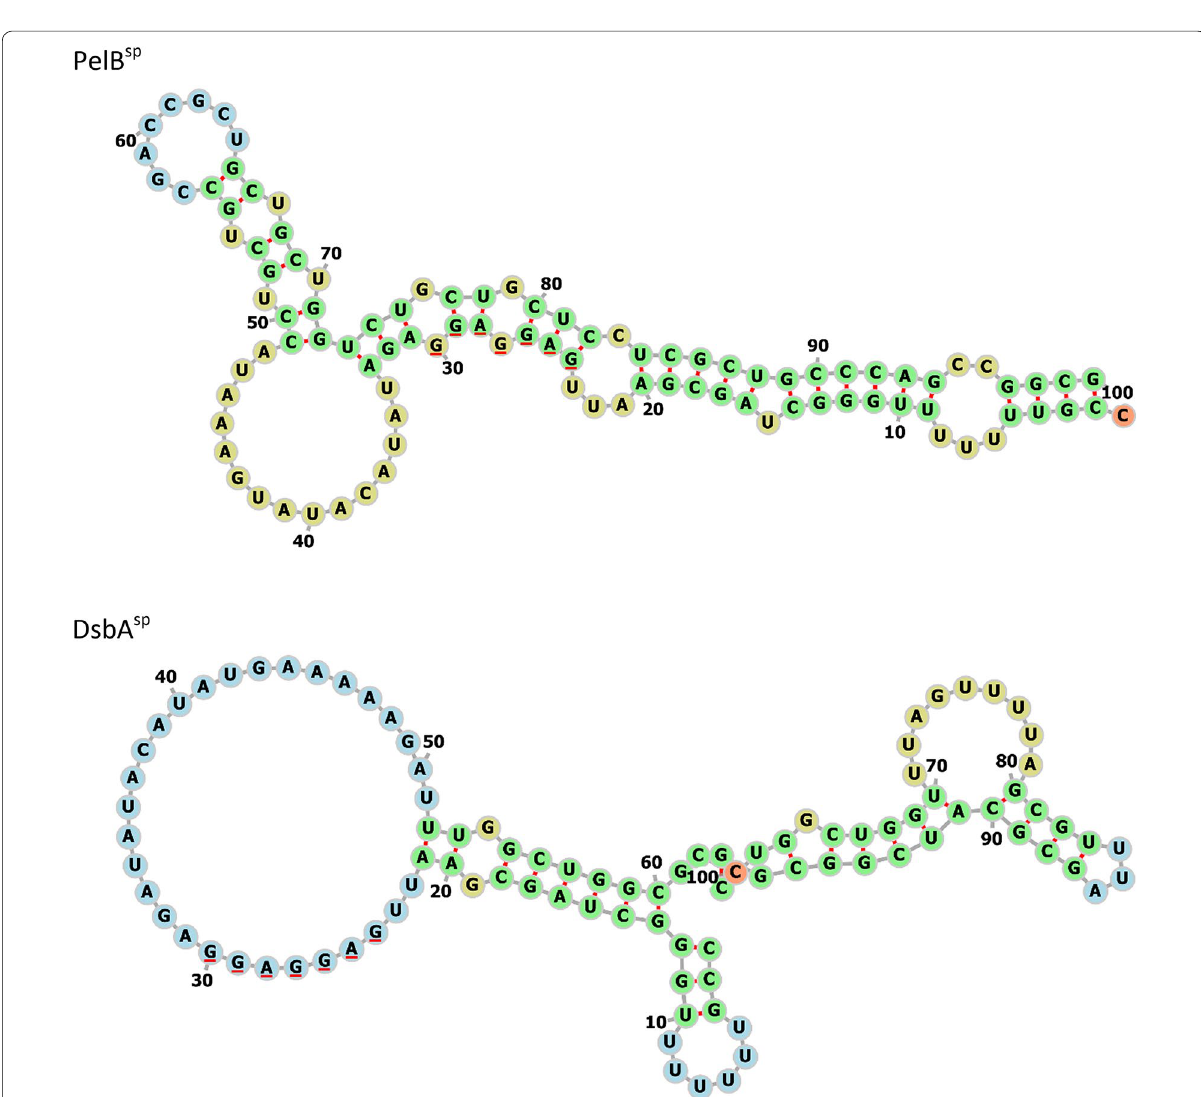
Fig. 8 Predicted mRNA structures for the PelB sp and DsbA sp . RNA structures were predicted using the RNAfold Webserver. Bases comprising the Shine-Dalgarno site are underlined red. Colour coding for bases: green, stems; red, multi loops at junctions; yellow, interior loops; blue, hairpin loops; orange, unpaired